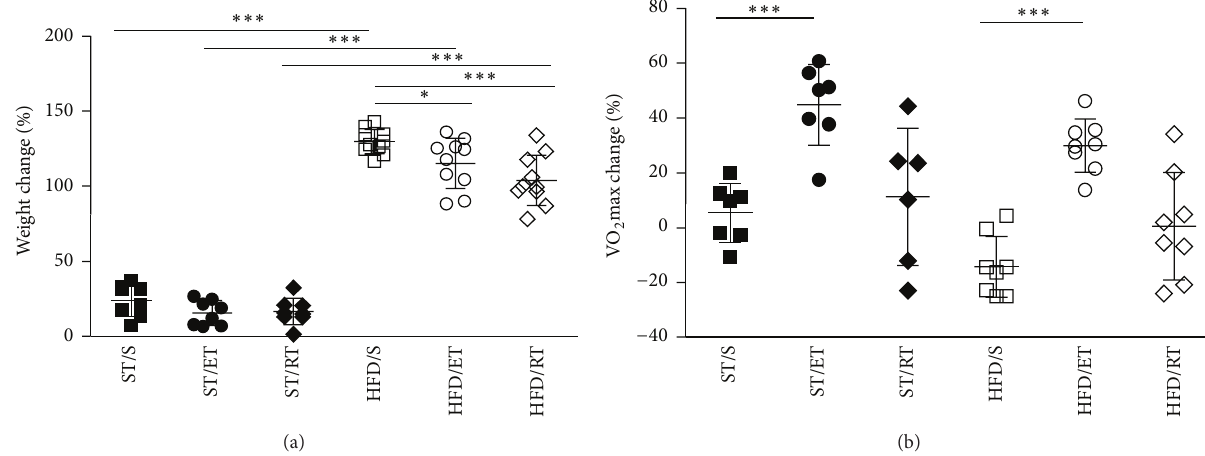
Figure 2: Percentage change in body weight (a) and VO 2 max (b) of untrained and trained mice following either a ST diet or a HFD for 10 weeks. ST: standard diet, HFD: high fat diet, S: sedentary, ET: endurance training, and RT: resistance training. ∗∗∗ 𝑝 < 0.001 , ∗ 𝑝 < 0.05